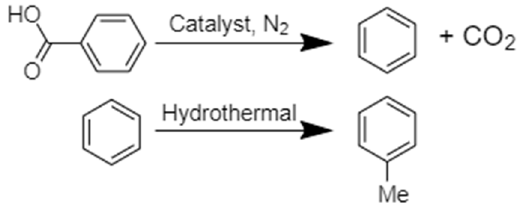
Figure 8. Reactions to convert benzoic acid to toluene.